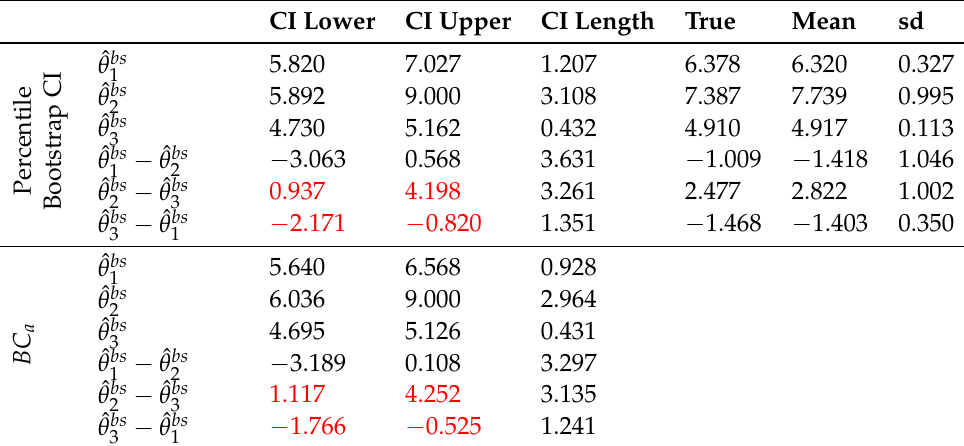
Table 1. The Percentile Bootstrap Confidence Interval (CI) and bias-corrected and accelerated boot- strap interval ( BC a ) for c = 10.3. The significance against H 0 : θ i = θ j is in red.